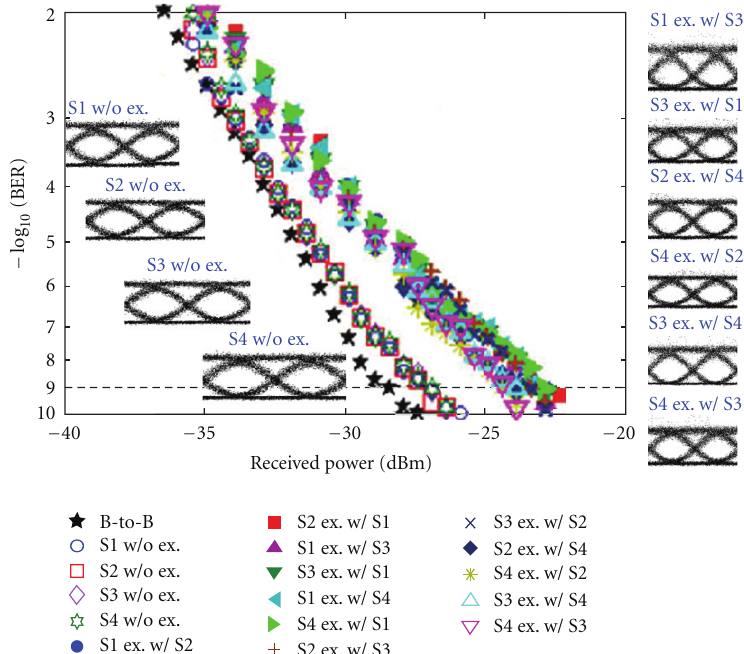
Figure 6: Measured eye diagrams and BER performance of 40Gbit/s time- and channel-selective data exchange between four WDM channels.